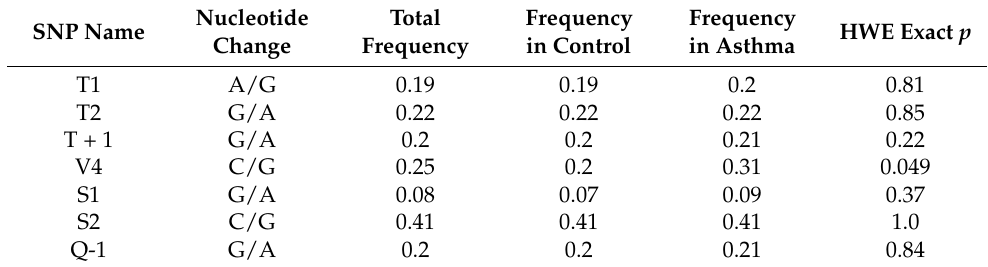
Table 3. Minor allele frequencies and their association analyses in